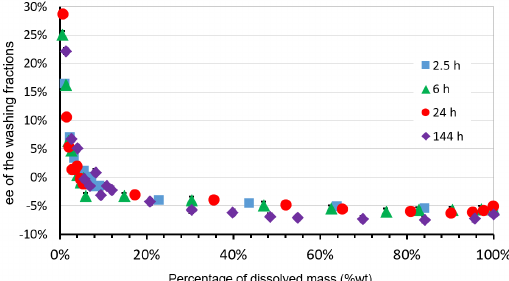
Figure 4. Enantiomeric excess of the different crystal washing fractions dissolved. The different profiles shown stand for the different filtration times at which crystals were filtered during PE (i.e., blue squares: 2.5 h, green triangle: 6 h, red circles: 24 h, purple lozenge: 144 h). Error bars are smaller than the size of the experimental points.